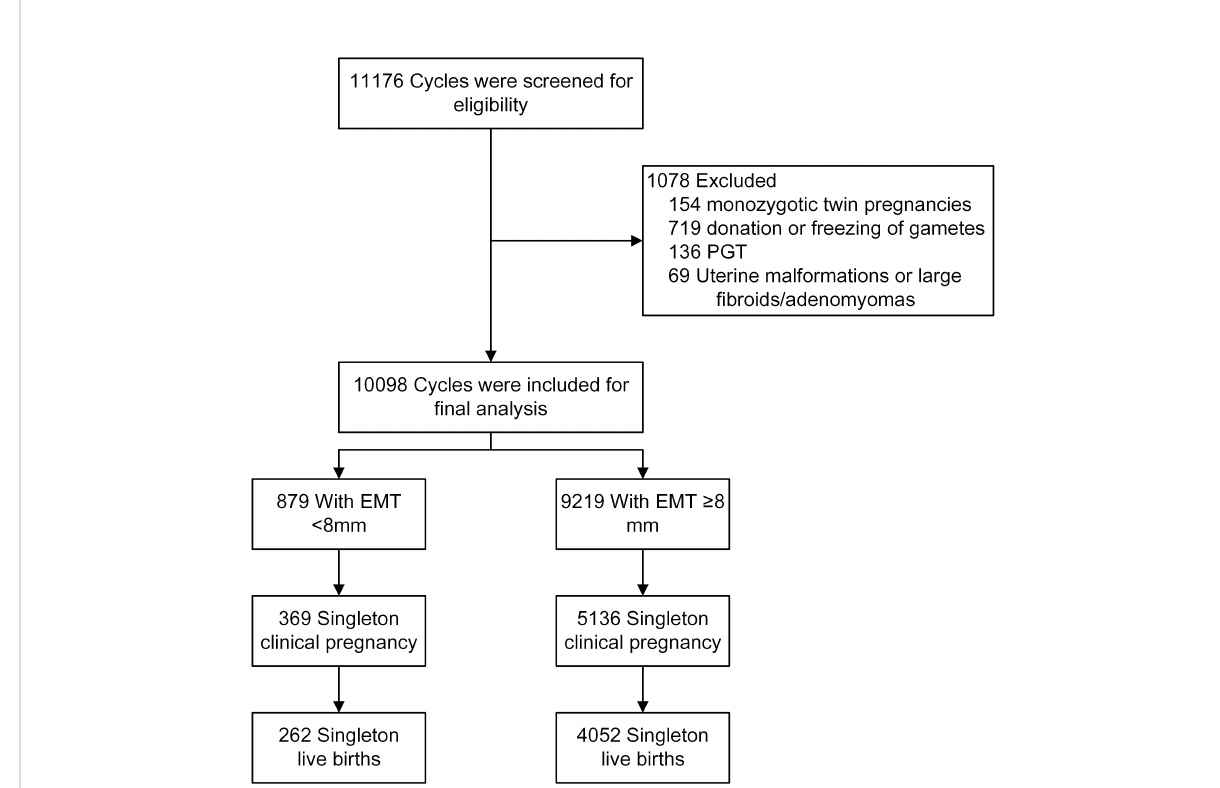
FIGURE 1 The fl ow chart of patient selection. EMT, endometrial thickness; PGT, preimplantation genetic